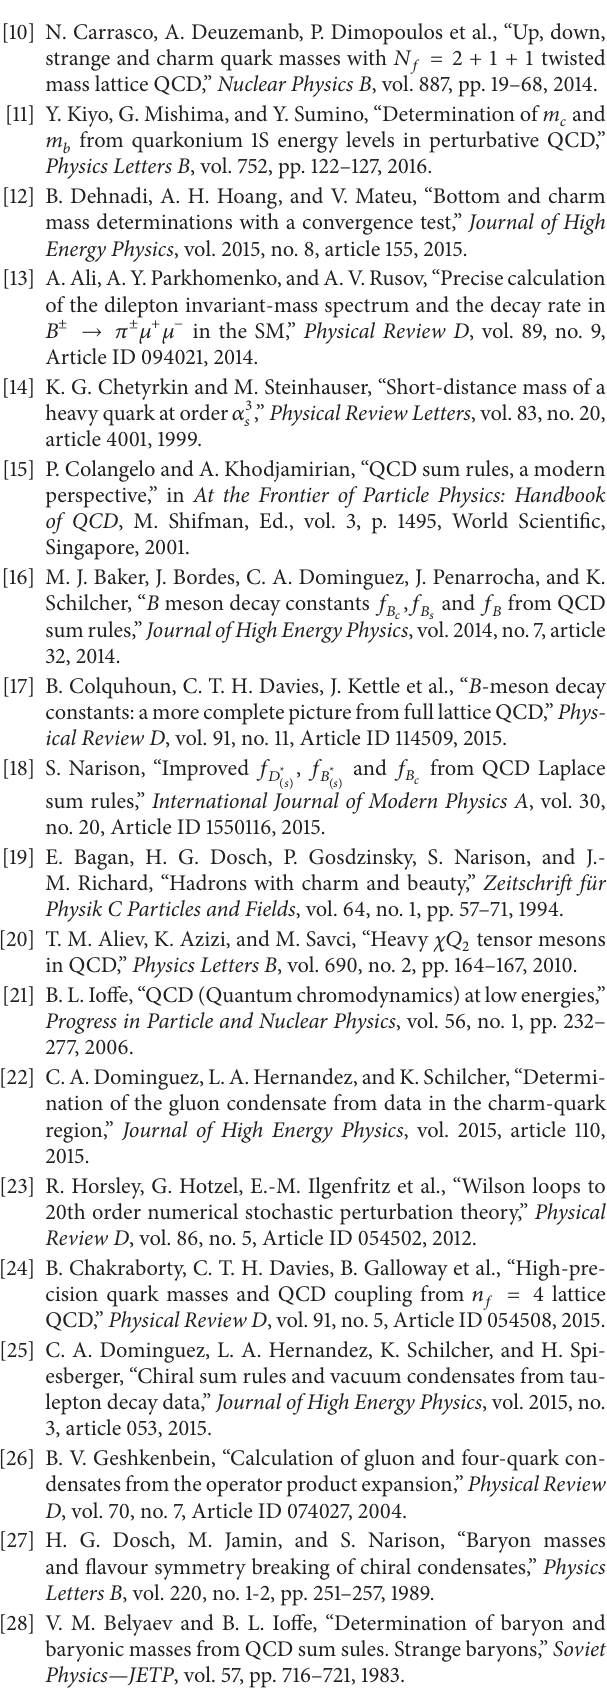
Table 2: Numerical results of decay widths at different lepton chan- nels.